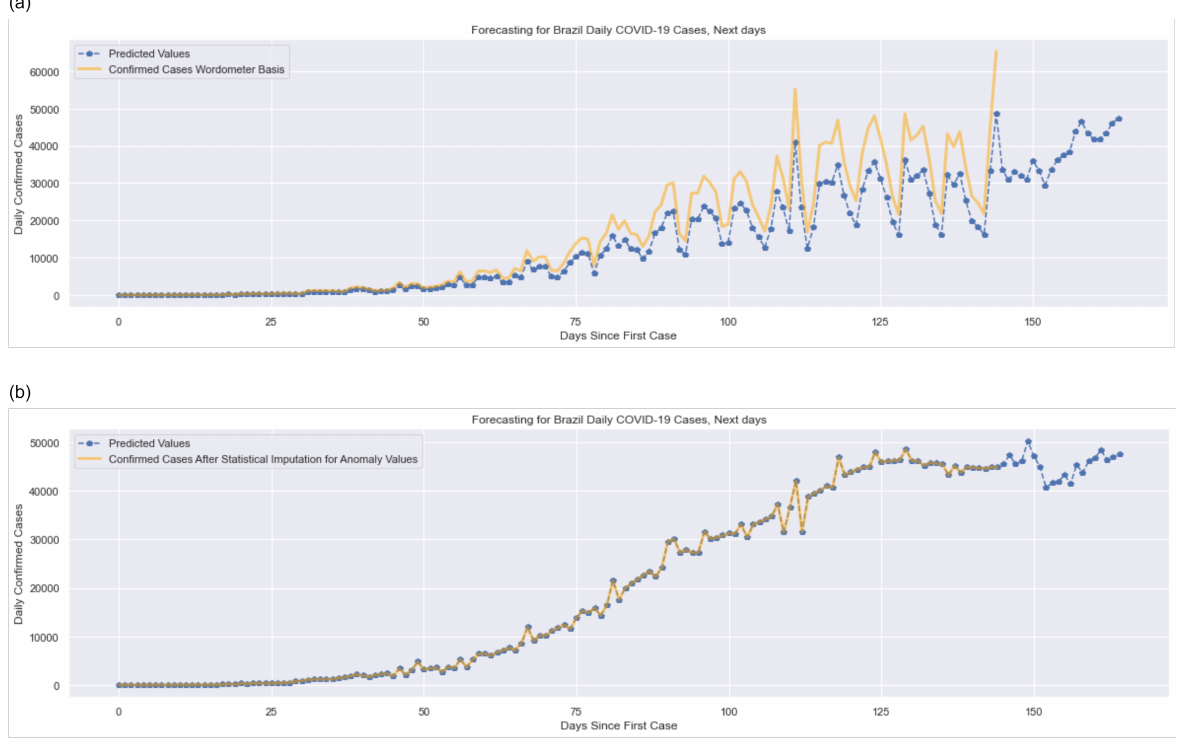
Figure 22. Prediction result for forecasting with treated data. In (a) we show the forecasting result for untreated data of daily COVID-19 cases in Brazil. In (b) we show the same prediction under-treated data using the statistical imputation method. Here it is observed that the prediction results obey the time series regime, since the unexpected seasonality was treated and removed from the time series. Thus, we observe that the application of this statistical imputation method allowed us to produce a more reliable prediction that obeys the natural evolution behavior of